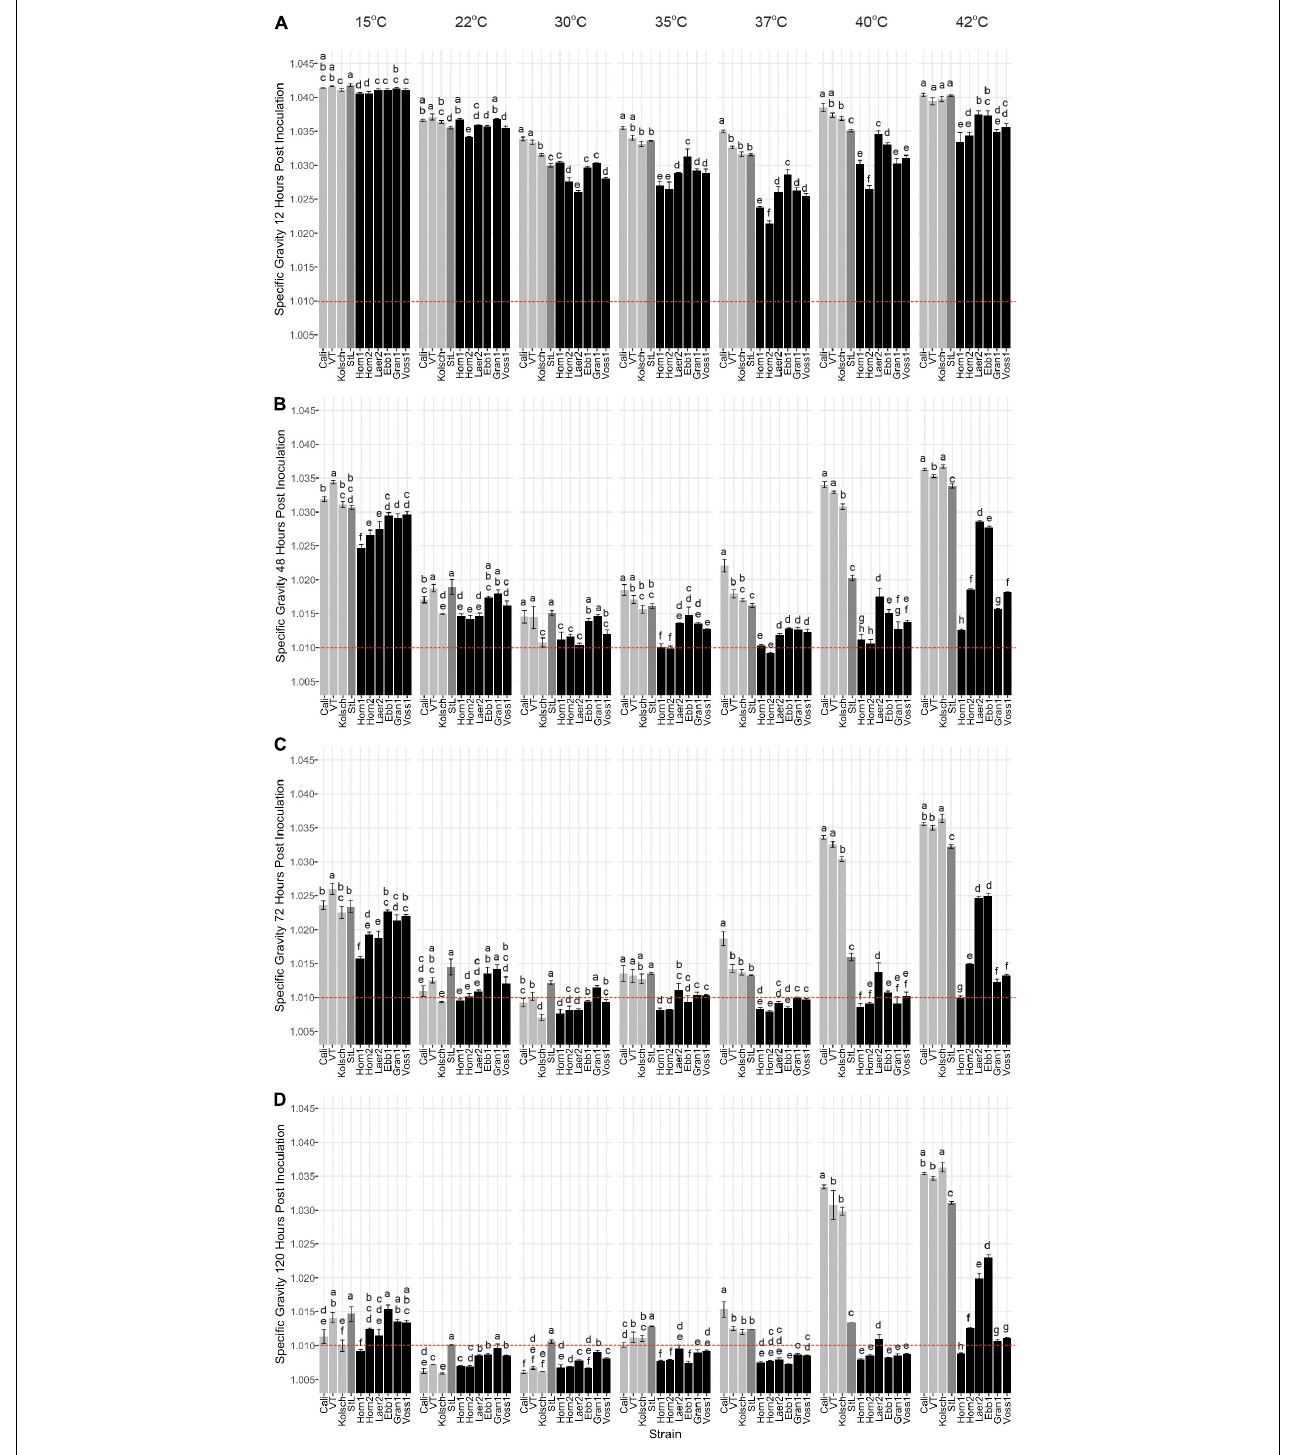
FIGURE 2 | Fermentation profiles comparing four commercial Saccharomyces cerevisiae ale strains and six Norwegian kveik isolates at each of the indicated temperatures between 15 and 42 ◦ C. Strains were pre-cultured and inoculated into wort as described in the Methods. The fermentation profiles were obtained by recording specific gravities throughout fermentations. Shown are specific gravities measured after (A) 12 h, (B) 48 h, (C) 72 h, and (D) 120 h of fermentation. Data points represent the mean of biological replicates ( n = 3) and error bars represent the standard deviation. Data was subjected to one-way ANOVA followed by Tukey’s HSD analysis of the mean difference in specific gravity between strains for each timepoint and temperature (Specific Gravity ∼ Strain). Mean values assigned with a common letter are not significantly different by the HSD-test at the 5% level of significance within the same temperature. Light gray bars are Beer 1, dark gray bars are Beer 2, and black bars are kveik